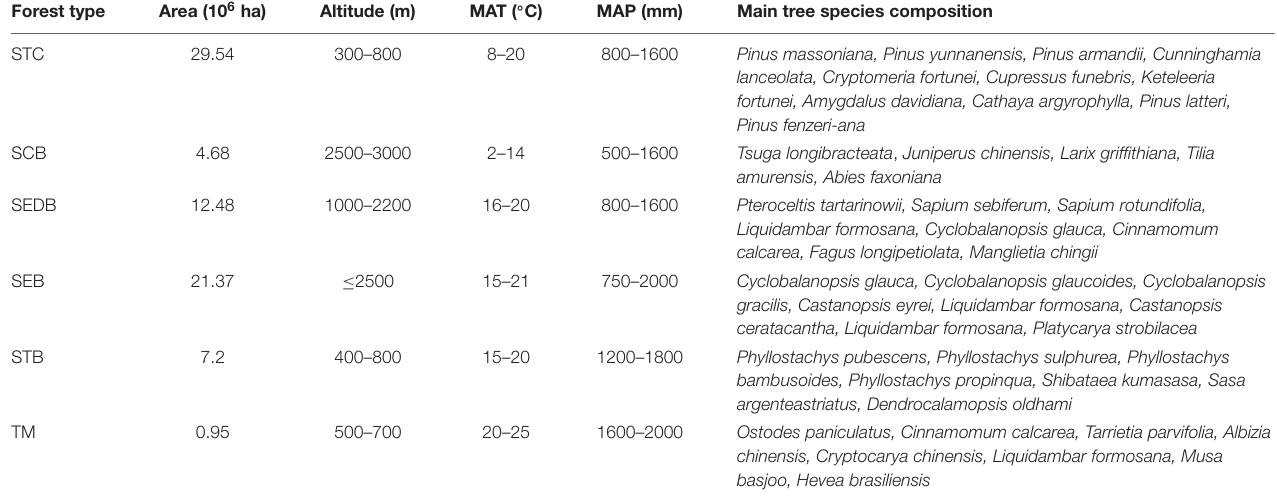
TABLE 1 | Properties of dominant forest types in southern